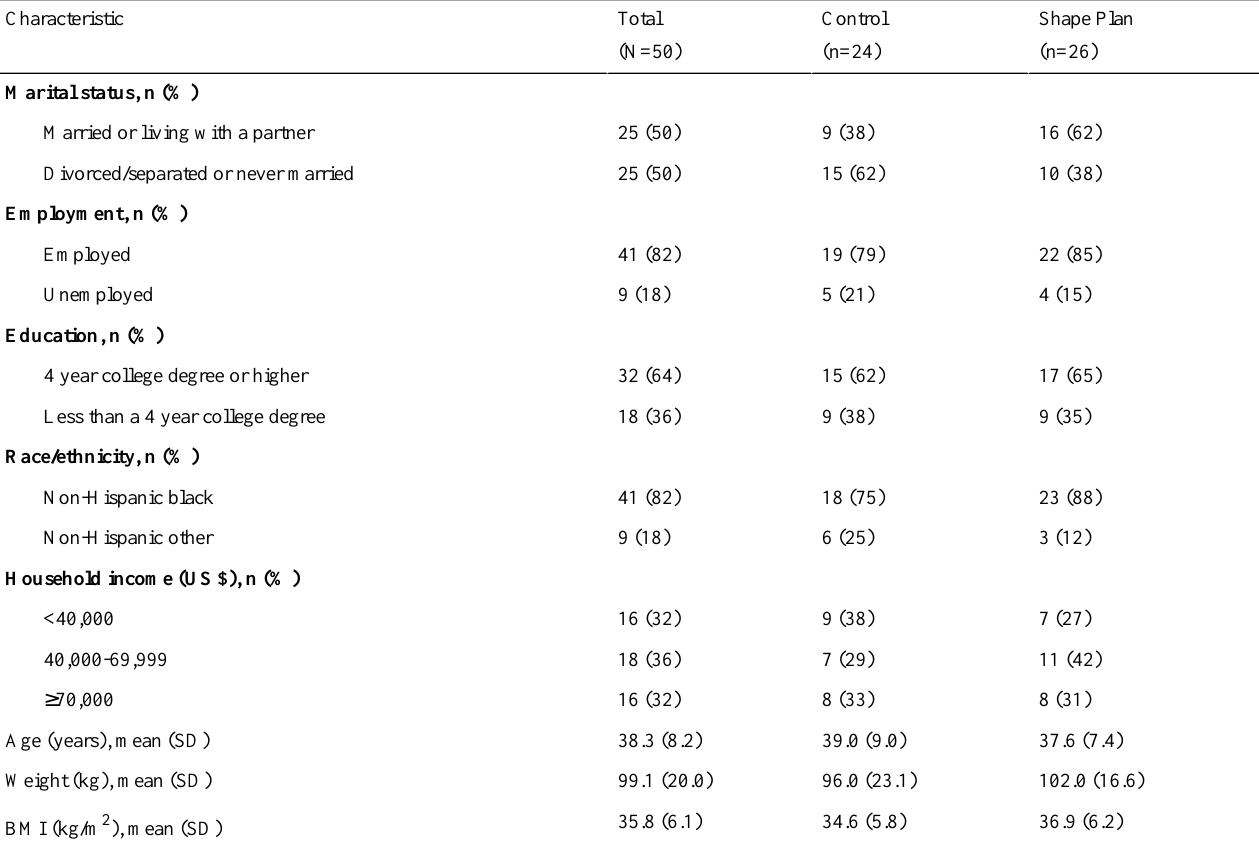
Table 1. Baseline characteristics of participants by study arm.